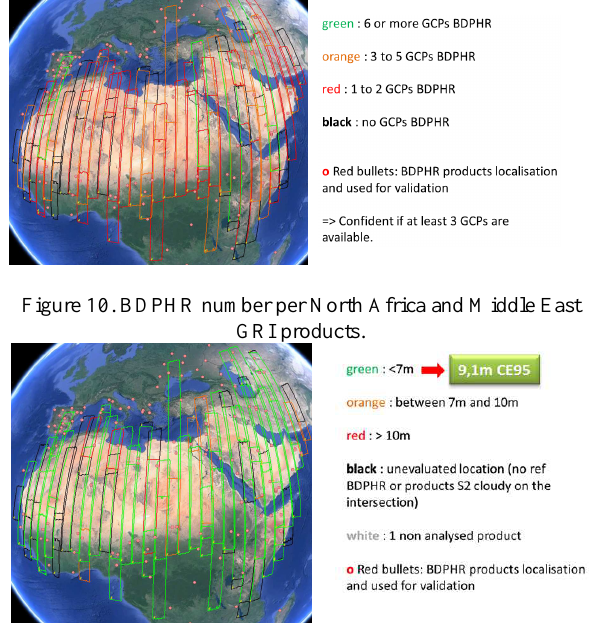
Figure 11. North Africa and Middle East GRI mean geolocation performance.